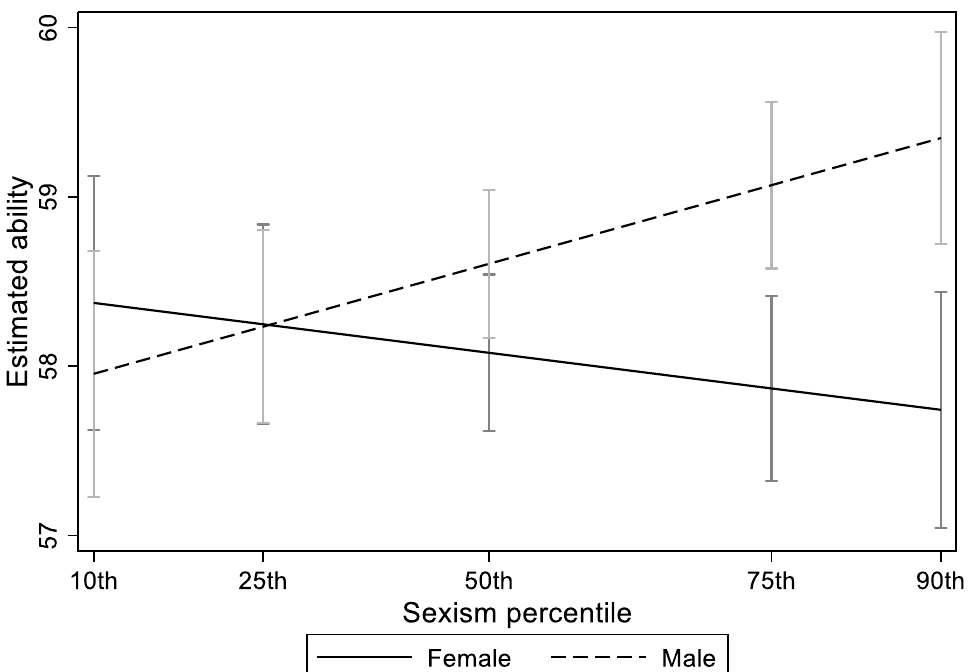
Fig. 5 Teachers’ sexist beliefs as a moderator of their ability ratings of boys and girls for the same student work. The bars indicate of the prediction